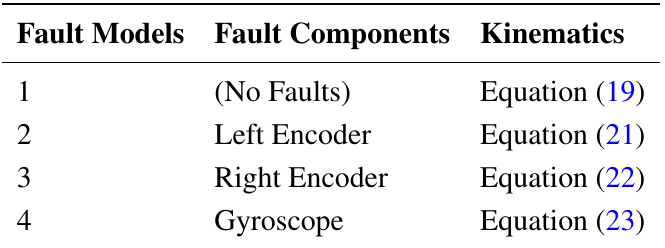
Table 1. Fault Models for Mobile